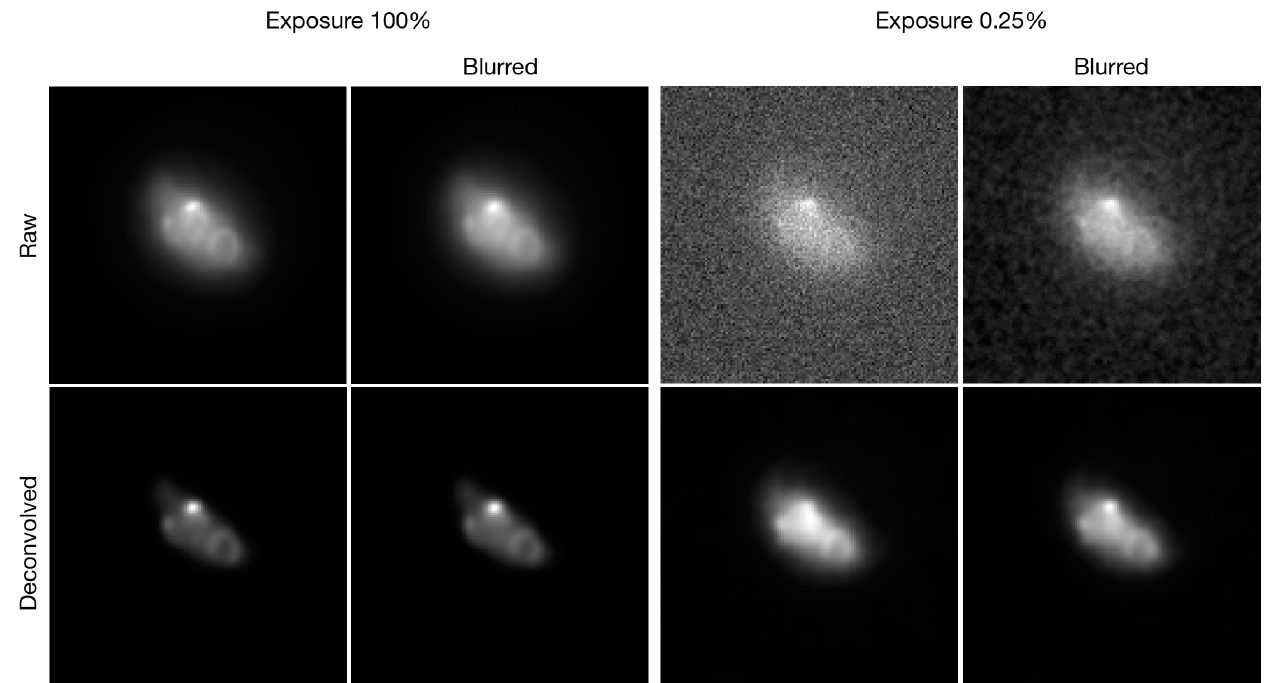
Figure 4. Effect of a Gaussian blur prefilter on deconvolution of widefield fluorescence data. These images of fluorescent yeast Zip1 filaments correspond to Figure 4 of Arigovindan et al. (2013). The two exposure levels represent strong (100%) or weak (0.25%) signals, respectively. Where indicated, the data were subjected either to a Gaussian blur with a radius of 1.00 pixel, or to deconvolution with Huygens, or to a Gaussian blur prefilter followed by deconvolution. The theoretical point spread function was based on imaging parameters supplied with